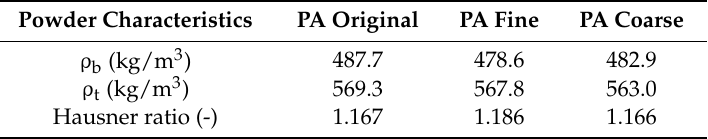
Table 2. Bulk density, tap density and Hausner ratio of the PA fractions.